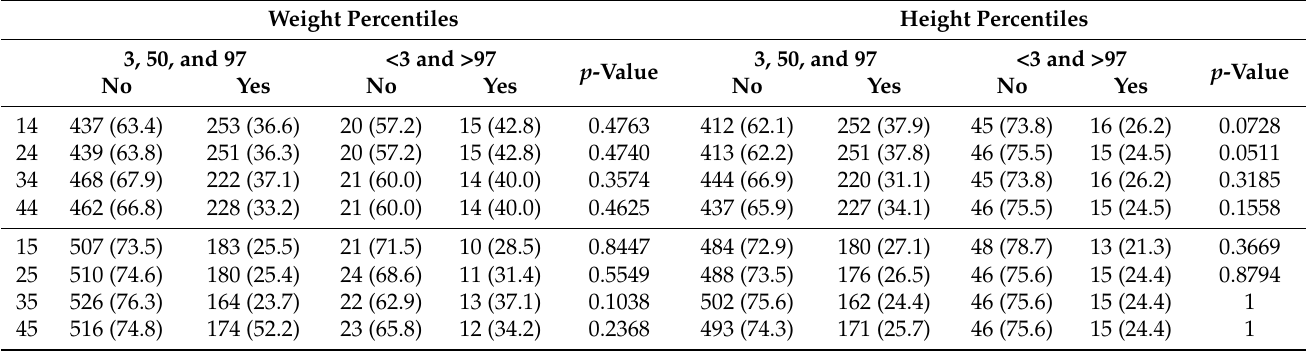
Table 5. Eruption of the premolar group and its relation by hemiarch with weight and height percentiles. Weight Percentiles Height Percentiles